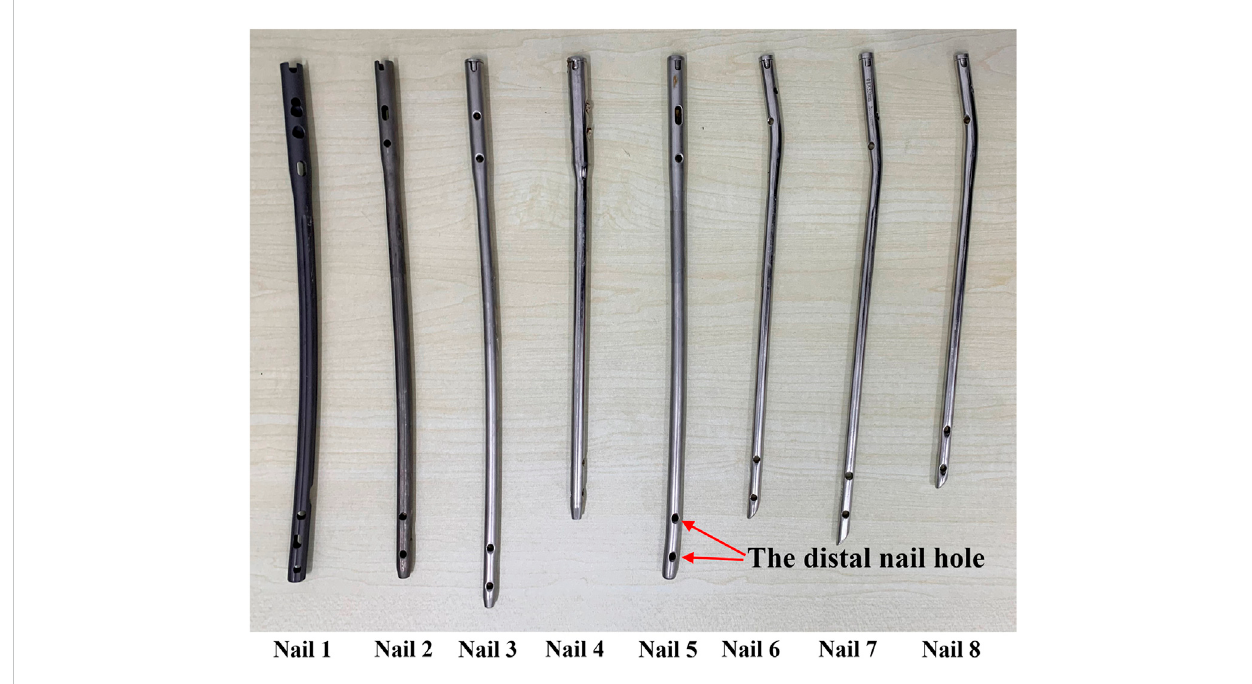
FIGURE 6 The intramedullary nails used in the experiments are one to eight from left to